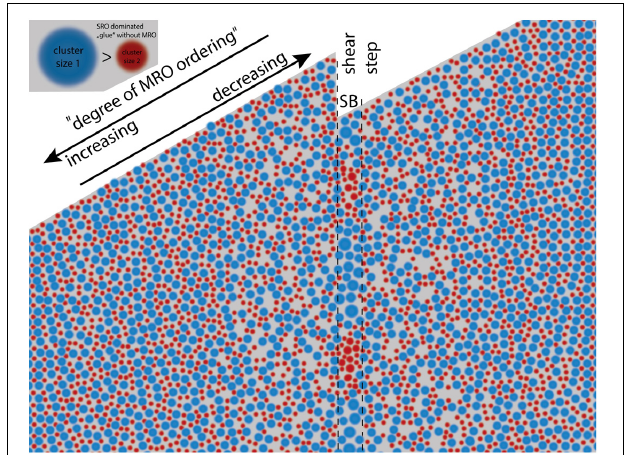
FIGURE 11 | Schematic illustration of the medium-range order (MRO) distribution in and around a shear band indicating the influence of the